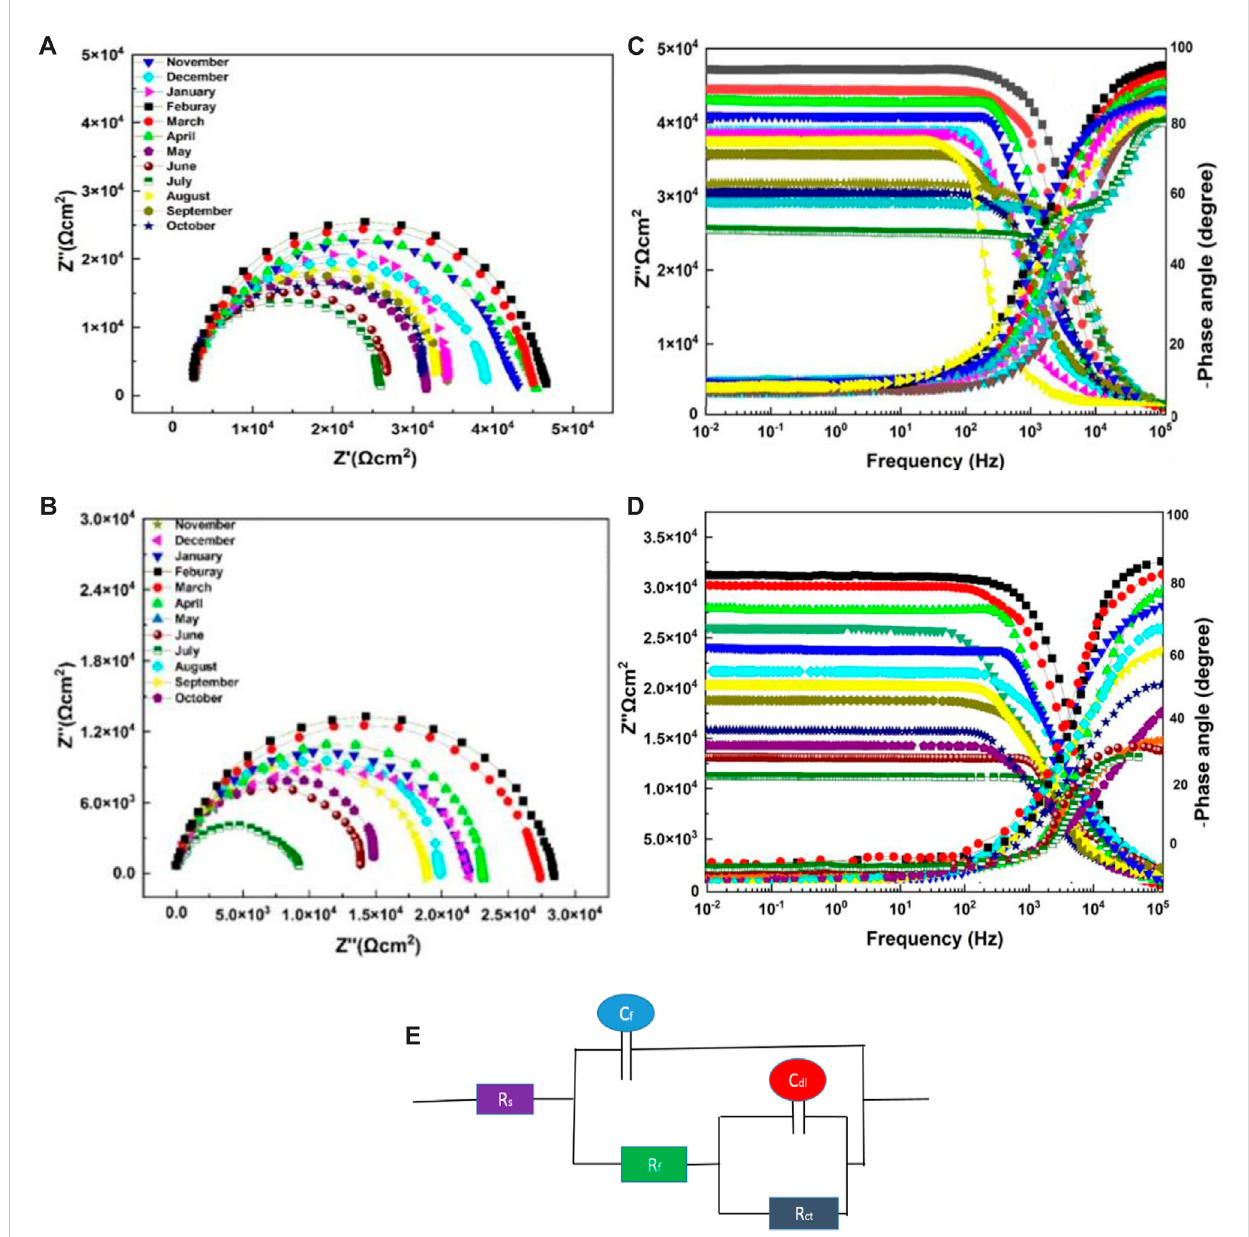
FIGURE 7 NyquistplotandBodeplotsforEISanalysisinanalkalinesolutionofNaOHwithpH11 (A) and (C) withZPPigment; (B) and (D) neatepoxy: (E) EECmodel.